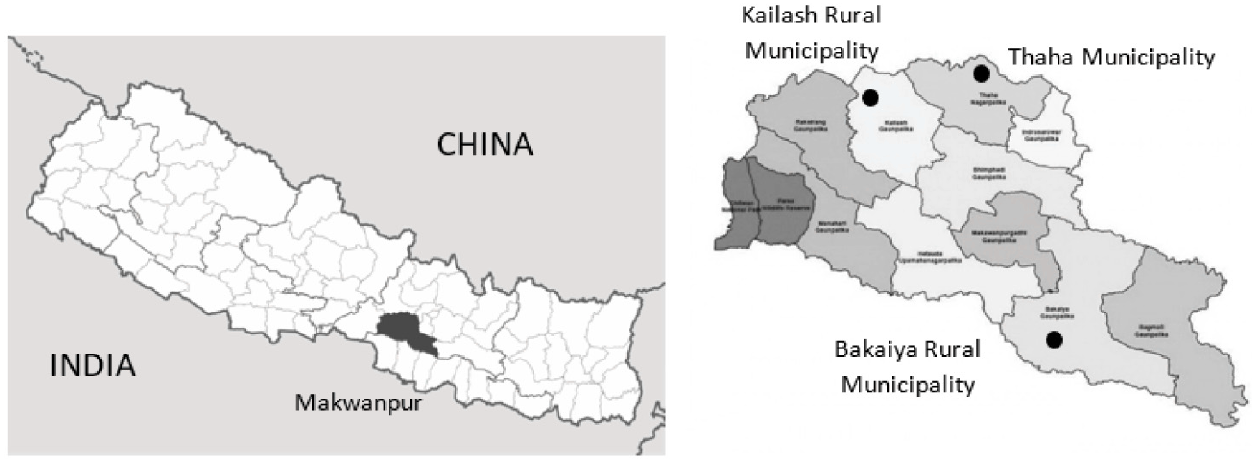
Figure 1. Geographical location of study. Note: This figure was adapted from the original image ( NordNordWest, 2019). This image is free to use under the creator’s licensing conditions. Licensing agreement available at https://creativecommons.org/licenses/by-sa/3.0/de/